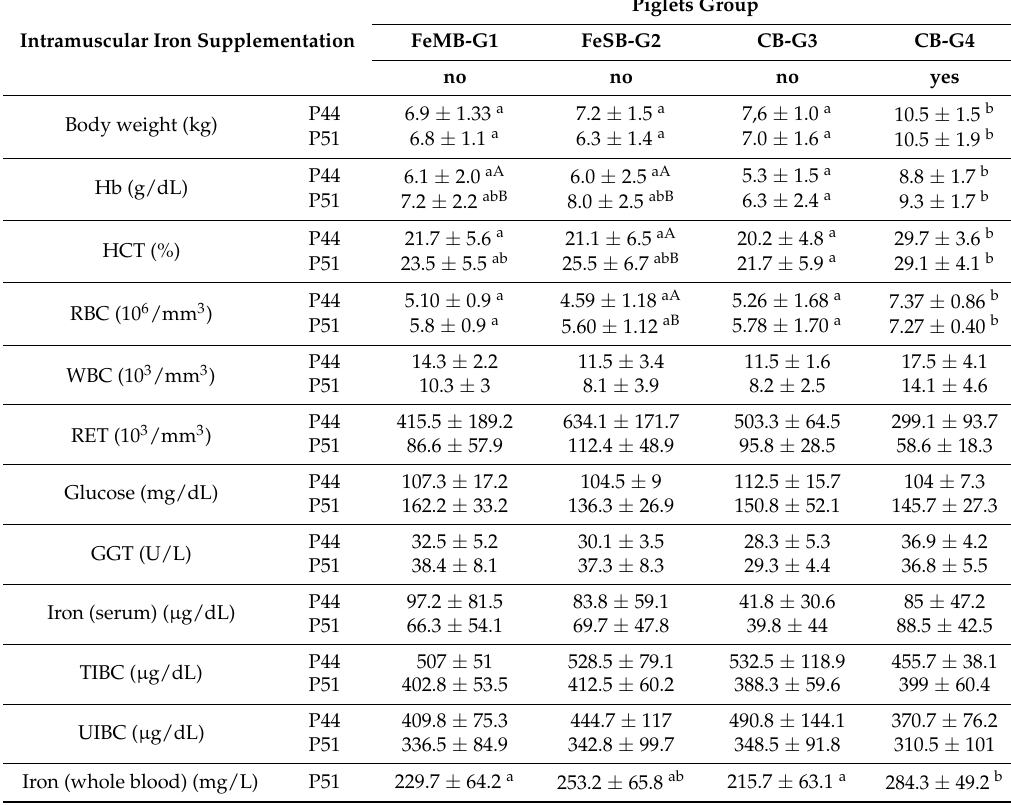
Table 4. Effect of bread administration on growth performance and blood parameters. Value are means ± SD. Means with different superscripts differ p < 0.05. Capital superscripts represent differences within the same group between P44 and P51. Lowercase superscript represent differences between the groups at the same experimental time. (BW: body weight; HCT: hematocrit; Hb: hemoglobin; RBC: red blood cells; WBC: white blood cells; RET: reticulocytes; GGT: gamma glutamyltransferase; TIBC: total iron binding capacity; UIBC: unsaturated iron binding capacity; TSAT: TIBC saturation